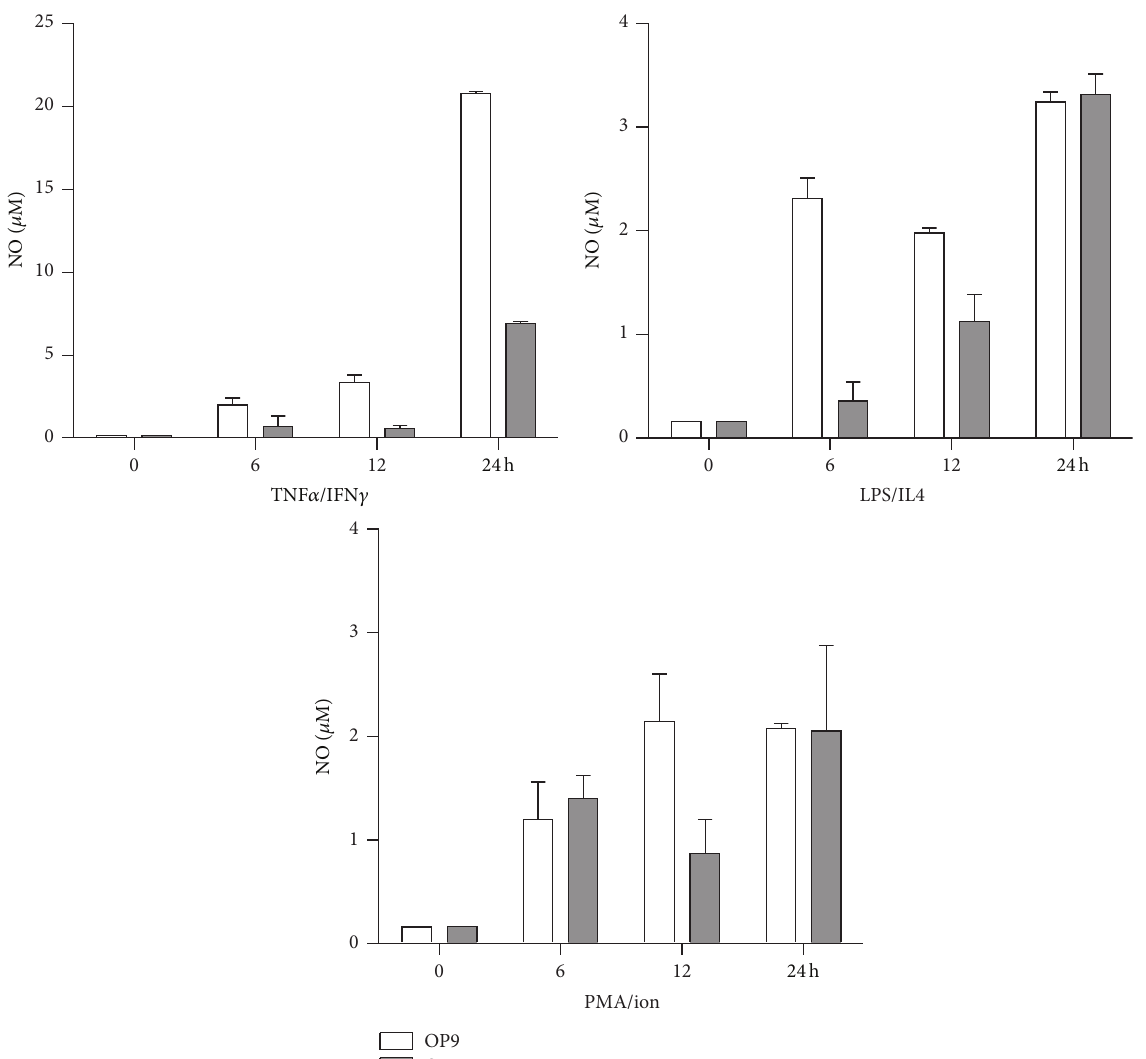
Figure 6: NO production in OP9 and OP9DL1 cells in the presence of different stimulators. OP9 and OP9DL1 were stimulated with TNF 𝛼 /IFN 𝛾 (each 2 ng/mL), LPS (10 𝜇 g/mL)/IL4 (25ng/mL), or PMA (50ng/mL)/ion (1 𝜇 g/mL) for 24 h, respectively. Supernatants were collected at 6, 12, and 24h and used for NO assay,